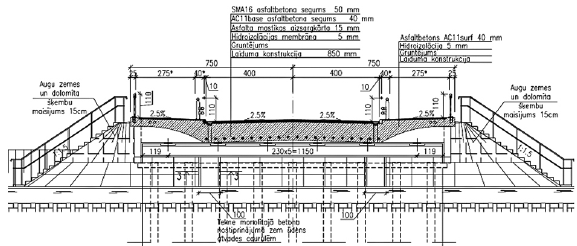
Fig. 12. Cross section of a bridge over Pedele river in Valka.